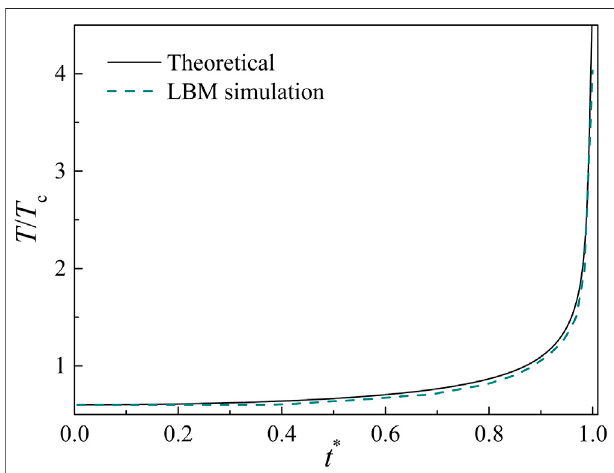
FIGURE 3 | Comparative calculation of the cavitation bubble temperature vs. time.